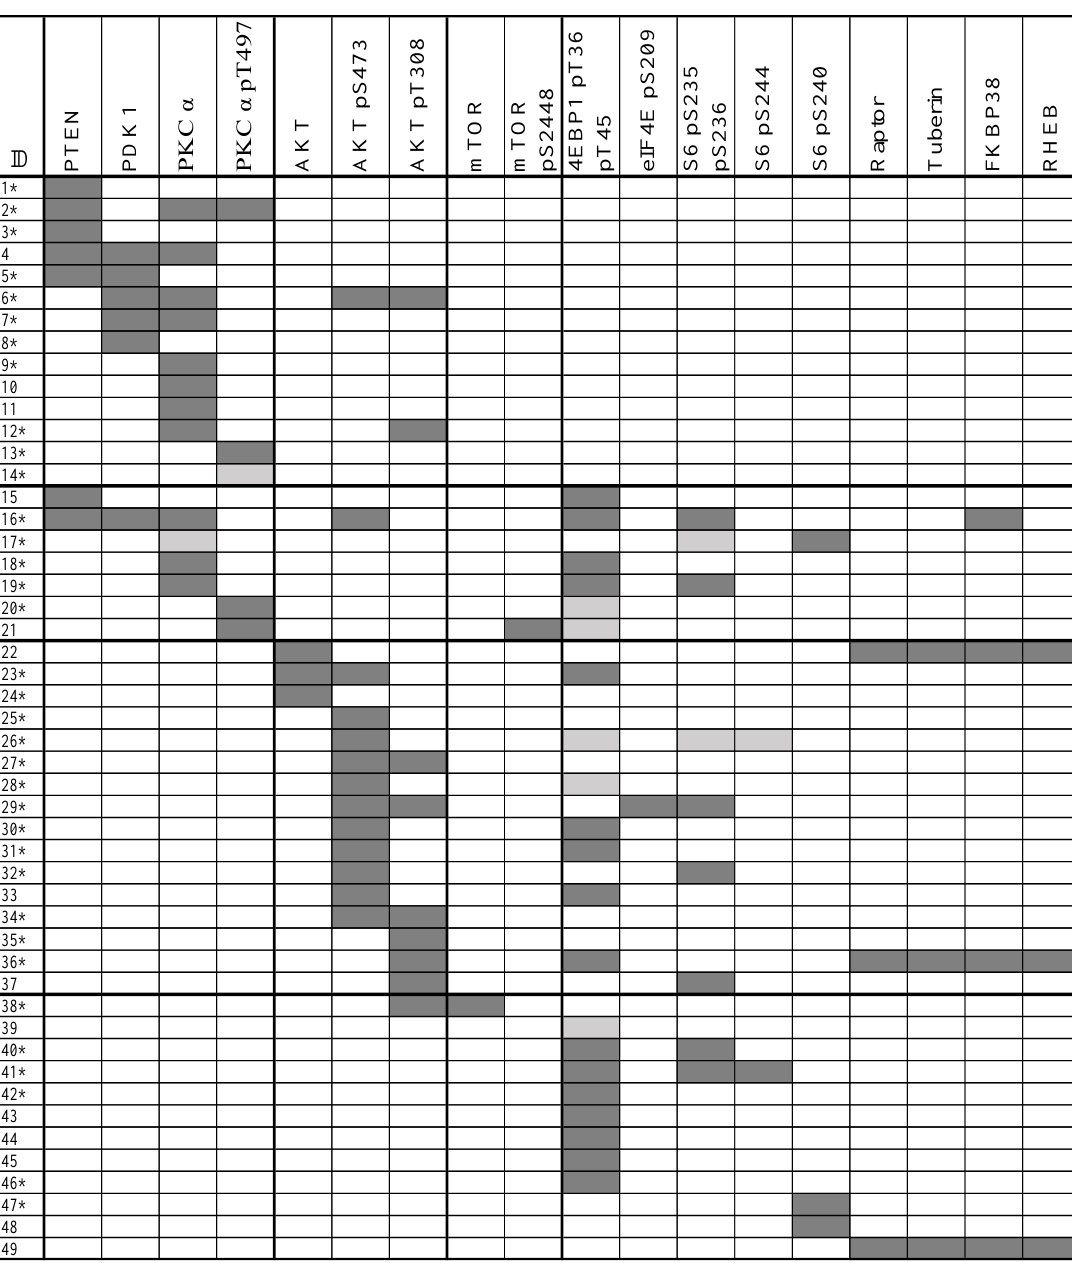
Figure 1. Clonal heterogeneity of primary human acute myeloid leukemia (AML) cell samples; an overview of the 49 patients showing dual populations when investigating activation of the phosphatidylinositol-3-kinase-Akt-mechanistic target of rapamycin (PI3K-Akt-mTOR) pathway. The cells were incubated in medium alone (all patients), with insulin alone and with insulin and a pathway inhibitor (rapamycin, GDC-0941; only an unselected subset of patients). Dark grey means that dual populations were detected in all cultures with and without treatment, and light grey indicates detection only for some cultures. Patient samples analyzed for inhibition by mTOR inhibitor rapamycin and PI3K inhibitor GDC-0941 are indicated by an asterisk ( * ). For each of the 49 patients, clonal heterogeneity was detected only for some of the 18 mediators. Nineteen of the patients showed dual population for only one of any of the 18 mediators, 16 patients showed dual populations for two mediators, and dual populations for three mediators was found for seven patients. Thus, for the majority of these patients, dual AML cell populations were detected only by one or a few of the tested mediators, and dual populations for four to seven pathway mediators were observed only for seven patients.